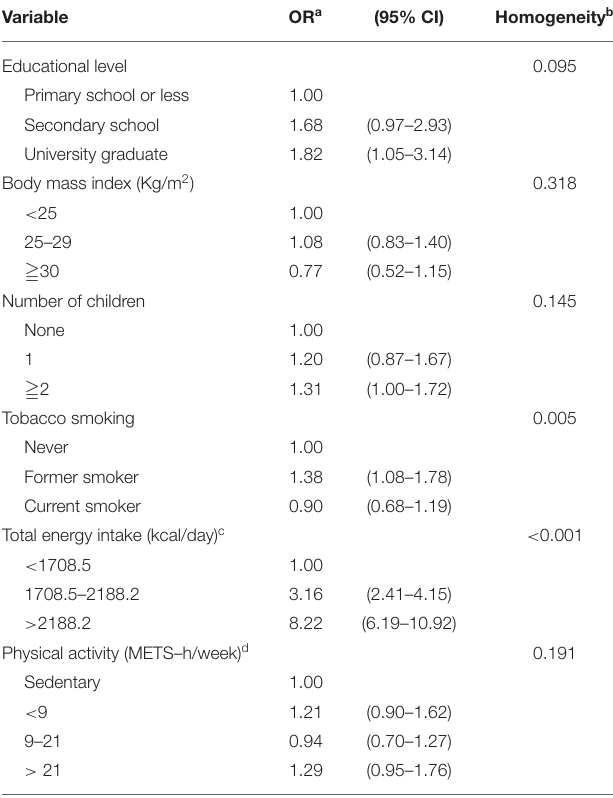
SENC, Spanish society of community nutrition. a Odds ratio adjusted for all variables included in the table. b Test for homogeneity of adherence across categories of each variable. c In tertiles. d In tertiles of physically active